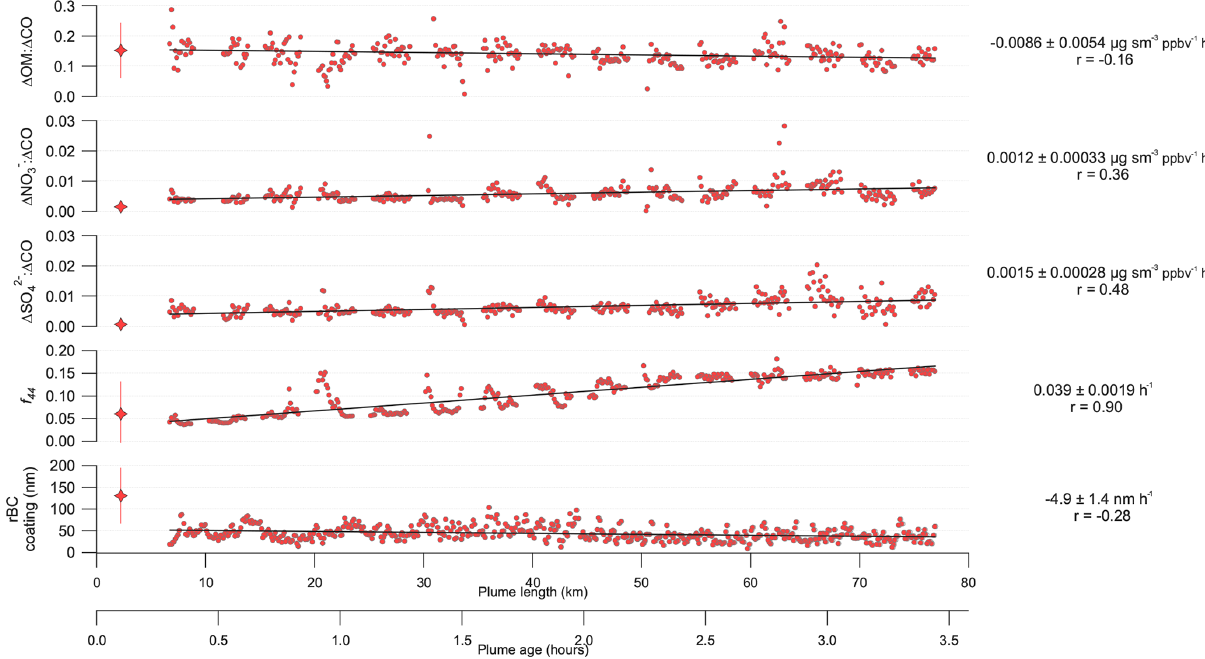
Figure 3. Various aerosol chemical and physical parameters as a function of plume length and age for the case study analysis from flight B737. Organic matter (OM), nitrate and sulfate are normalised by carbon monoxide (CO) to account for dilution of the smoke plume downwind. Further details on the calculations are provided in Sects. 2.2 and 3. Red star markers on the left-hand side of the figure are averaged across the fire overpass intercepts across the plume with the bars denoting the 2 σ standard deviation range around the mean value (OM, nitrate and sulfate ratios are taken from Hodgson et al., 2018). Individual data points are shown as red circles from the along-plume straight-and-level run (SLR), with a linear regression slope included to illustrate any apparent trends. Slopes of the linear regression are given on the right-hand side of the figure along with their 95% confidence interval. The correlation coefficient, r , is also